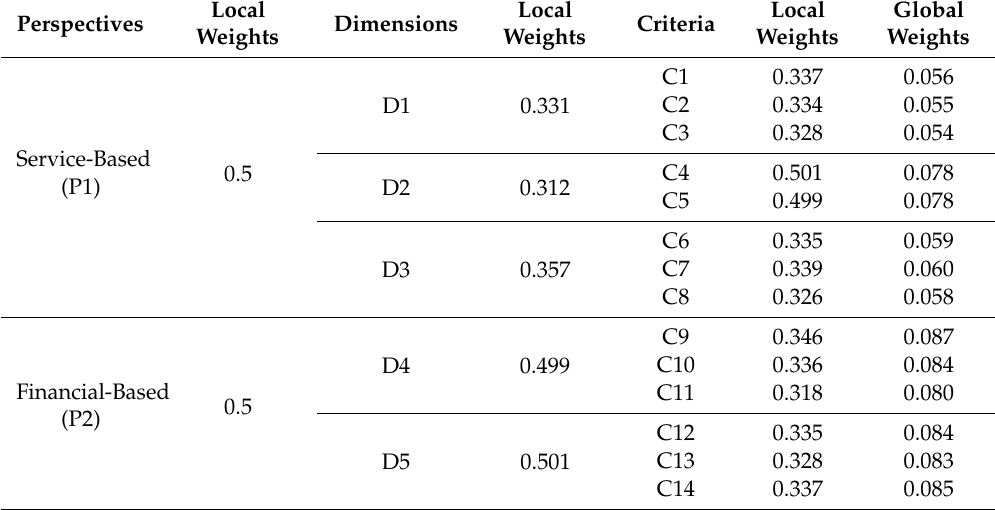
Table 11. Local and global weights for the dimensions and criteria of universal health coverage.